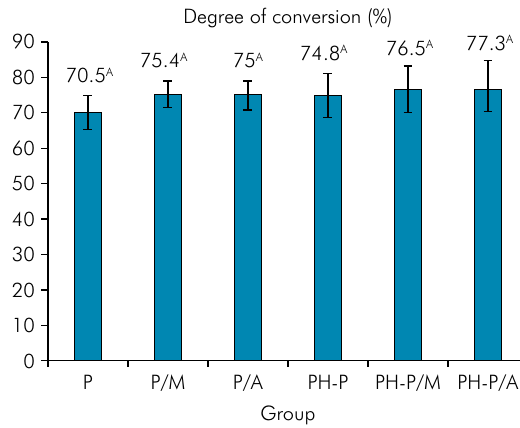
Figure 5. Degree of conversion results.